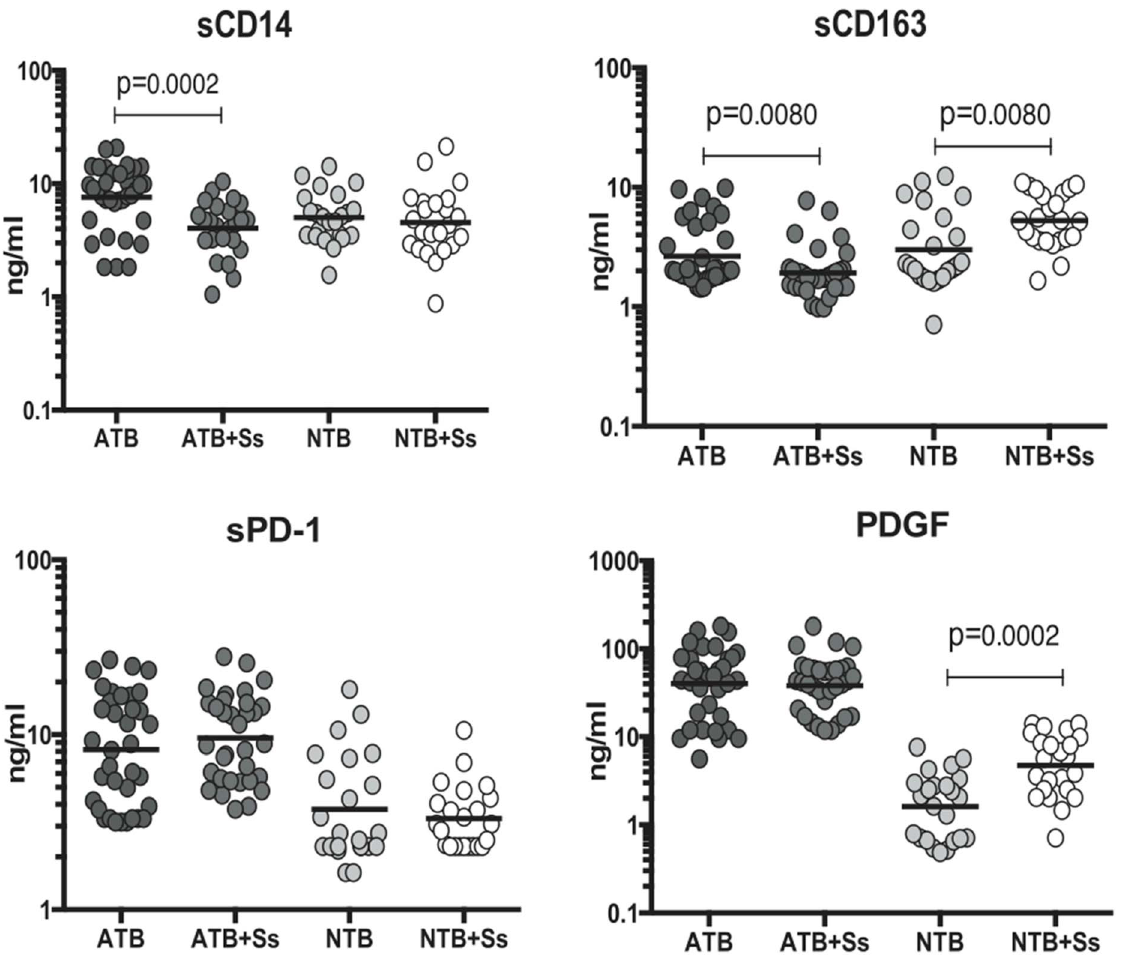
Figure 3. Helminth infections are associated with diminished plasma levels of sCD14 and sCD163 in active TB. The plasma levels of systemic immune activation markers (sCD14, sCD163, sPD-1 and PDGF) were measured by ELISA in active pulmonary TB individuals with (ATB + Ss, n=36) or without Strongyloides coinfection (ATB, n=33) and in non-TB infected individuals with (NTB + Ss, n=23) or without Strongyloides coinfection (NTB, n=23). The results are shown as scatterplots with each circle representing a single individual and the bar representing the geometric mean. P values were calculated using the Kruskal-Wallis test with Dunn’s multiple comparisons (* p , 0.05, ** p , 0.01, *** p , 0.001, **** p ,